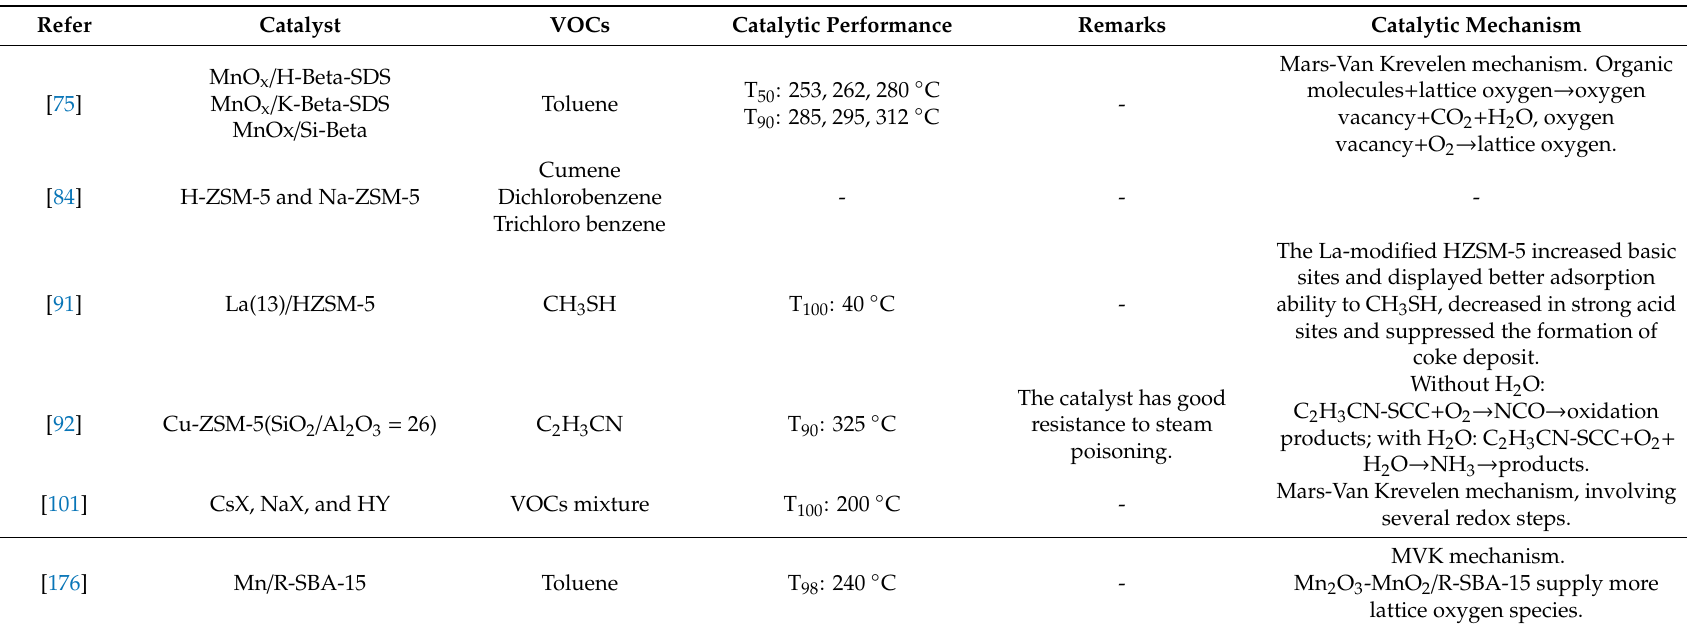
Table 8. Concentrated oxidation catalysts for catalytic combustion of